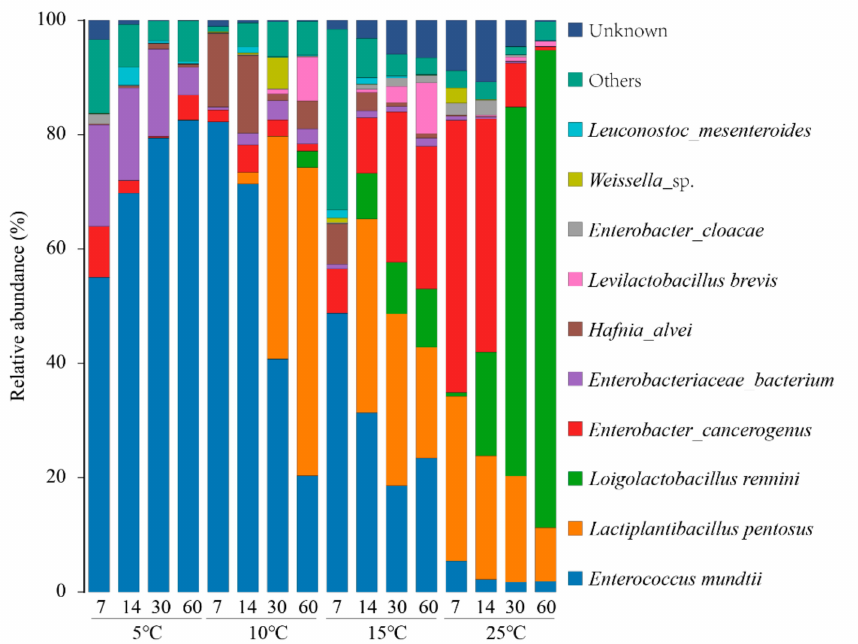
Figure 4. The microbial community of oat silages at the species level revealed by SMRT Cell. L. pentosus was exclusively identified in oat silage at 10 ◦ C, 15 ◦ C, and 25 ◦ C, and became to be the most abundant species at 10 ◦ C after 60 days of ensiling. Agarussi et al. have performed the trail of inoculating silage with L. pentosus , and the results showed that it had strong ability of producing lactic acid and reducing pH [31]. According, L. pentosus might be an interesting species for the development of LAB inoculants for cold